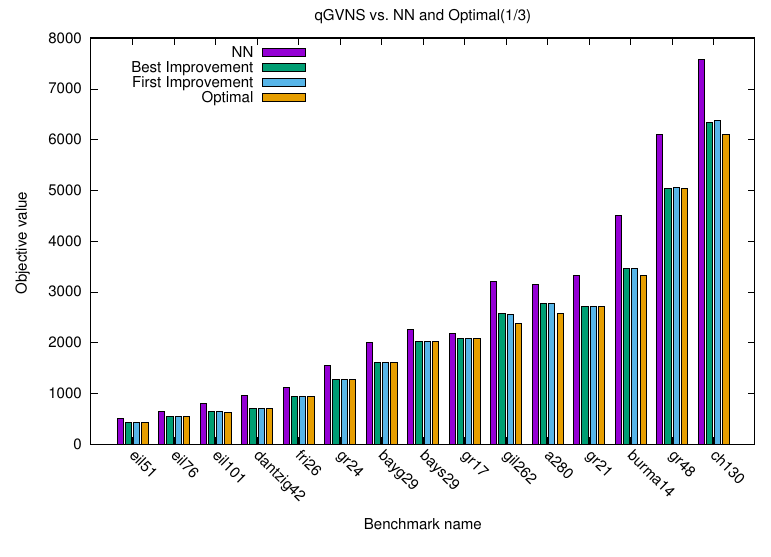
Figure 1. NN vs. GVNS vs. OV